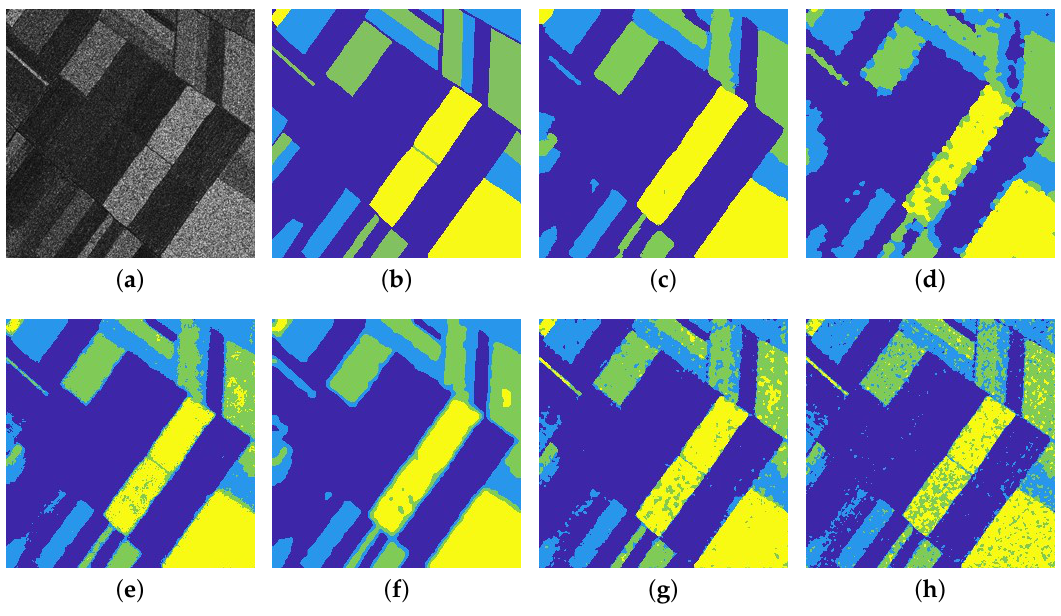
Figure 16. Segmentation results: ( a ) experimental image, ( b ) ground truth, ( c ) proposed, ( d ) FKPFCM [29], ( e ) NSFCM [1], ( f ) ILKFCM [28], ( g ) ALFCM [31], ( h ) CKSFCM